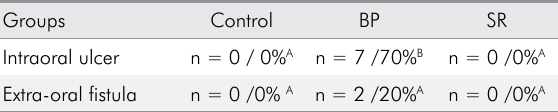
Table 1. Macroscopic evaluation of intraoral ulcer and extraoral fistula in C, BP, and SR